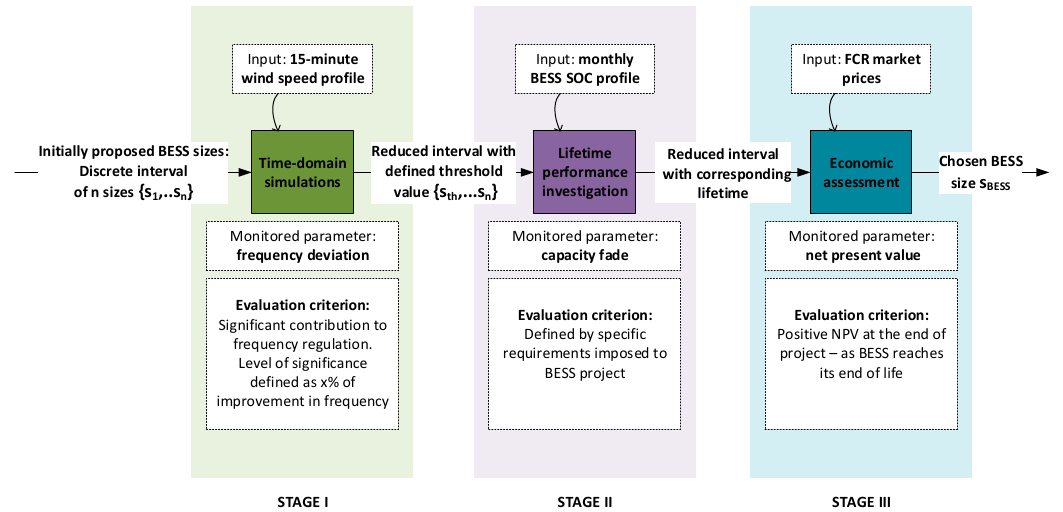
Figure 2. Three-stage sizing methodology for determination of the optimal BESS size.